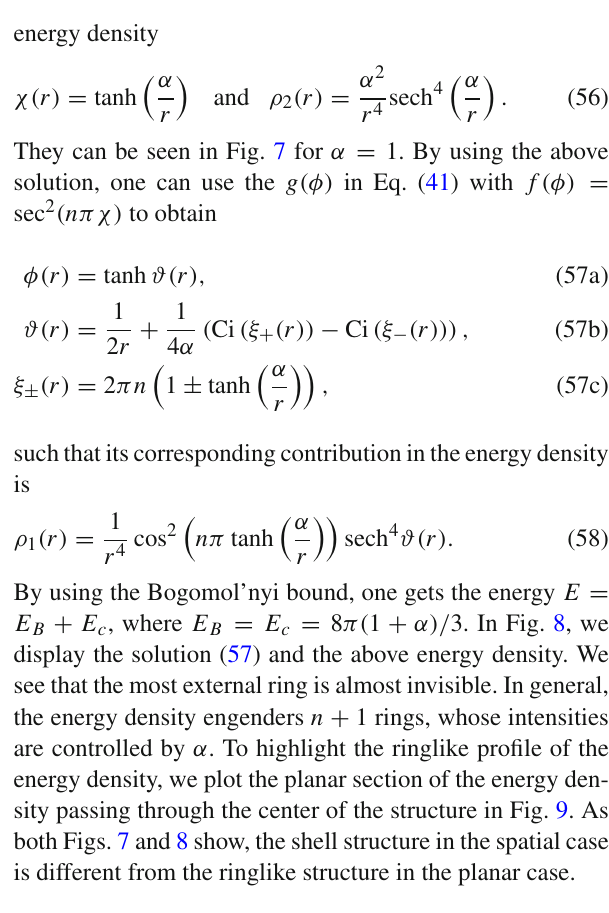
netic monopoles [30,31,40,41]. Another possibility refers to the case of Q-balls in the presence of U ( 1 ) gauged two- component model similar to the models recently investigated in Refs. [44,45]. The dielectric modification that we included in this work may suggest further research in the